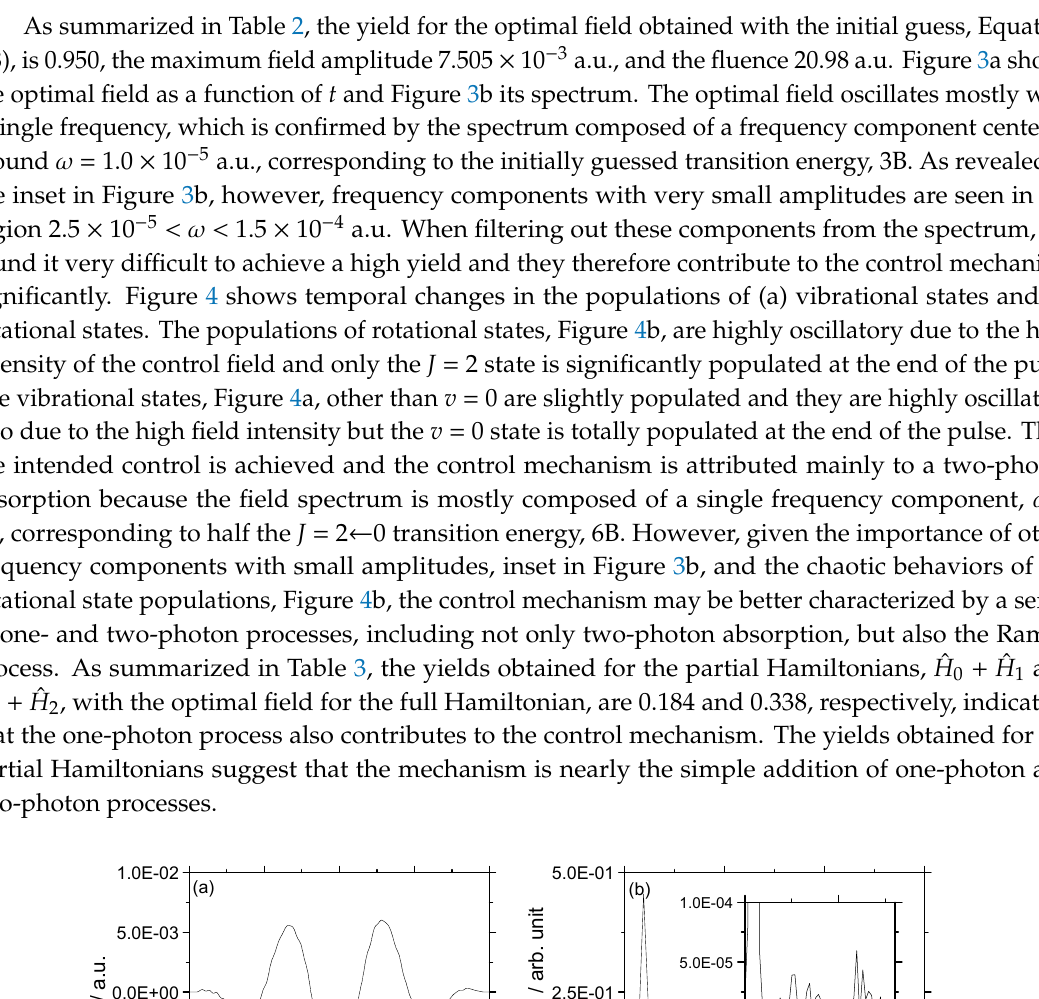
Figure 2. Temporal changes in state populations for the rotational excitation, ( v = 0, J = 0) → ( v = 0, J = 2), in the weak-field regime: (a) vibrational states; (b) rotational states. Table 3. Comparison of the yields with the full ( Ĥ 0 + Ĥ 1 + Ĥ 2 ) and partial Hamiltonians ( Ĥ 0 + Ĥ 1 and Ĥ 0 + Ĥ 2 ), obtained using the optimal fields for the full Hamiltonian. Init. Guess